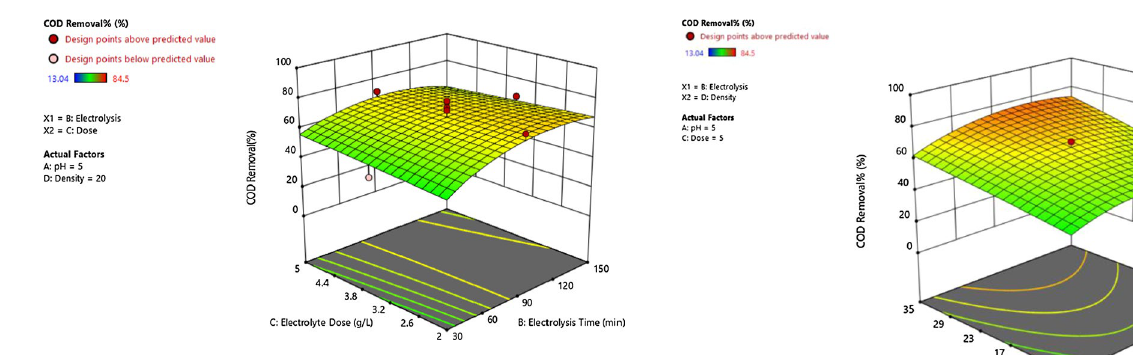
Fig. 8 3D surface plot of the graph represents the interaction of elec- trolysis time and electrolyte dose with respect to the COD % removal